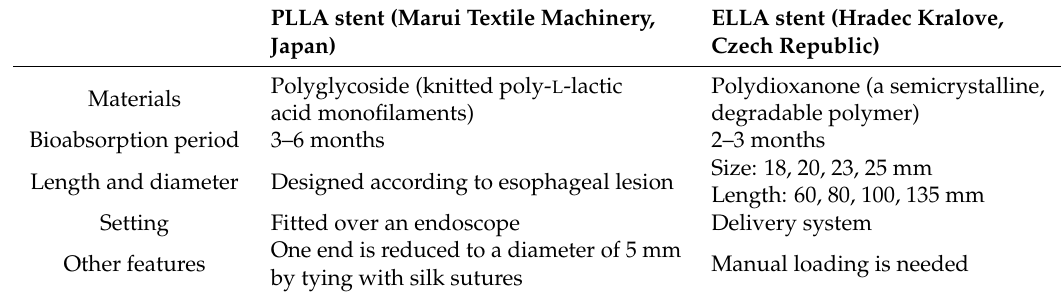
Table 2. Currently Available Biodegradable Stents for Benign Esophageal